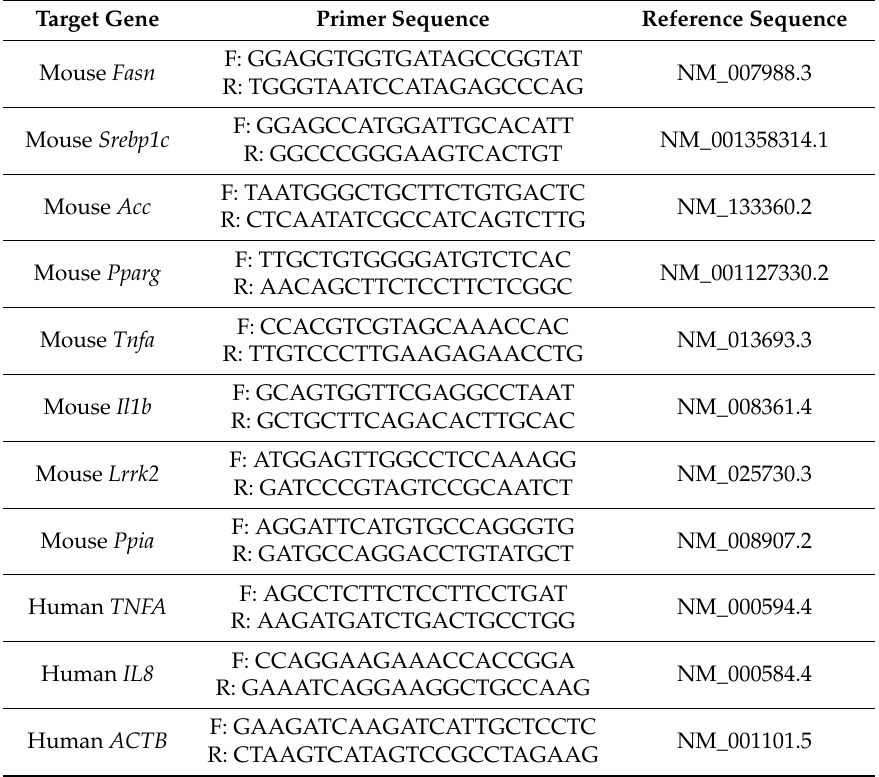
Table 1. Primer sets for real-time